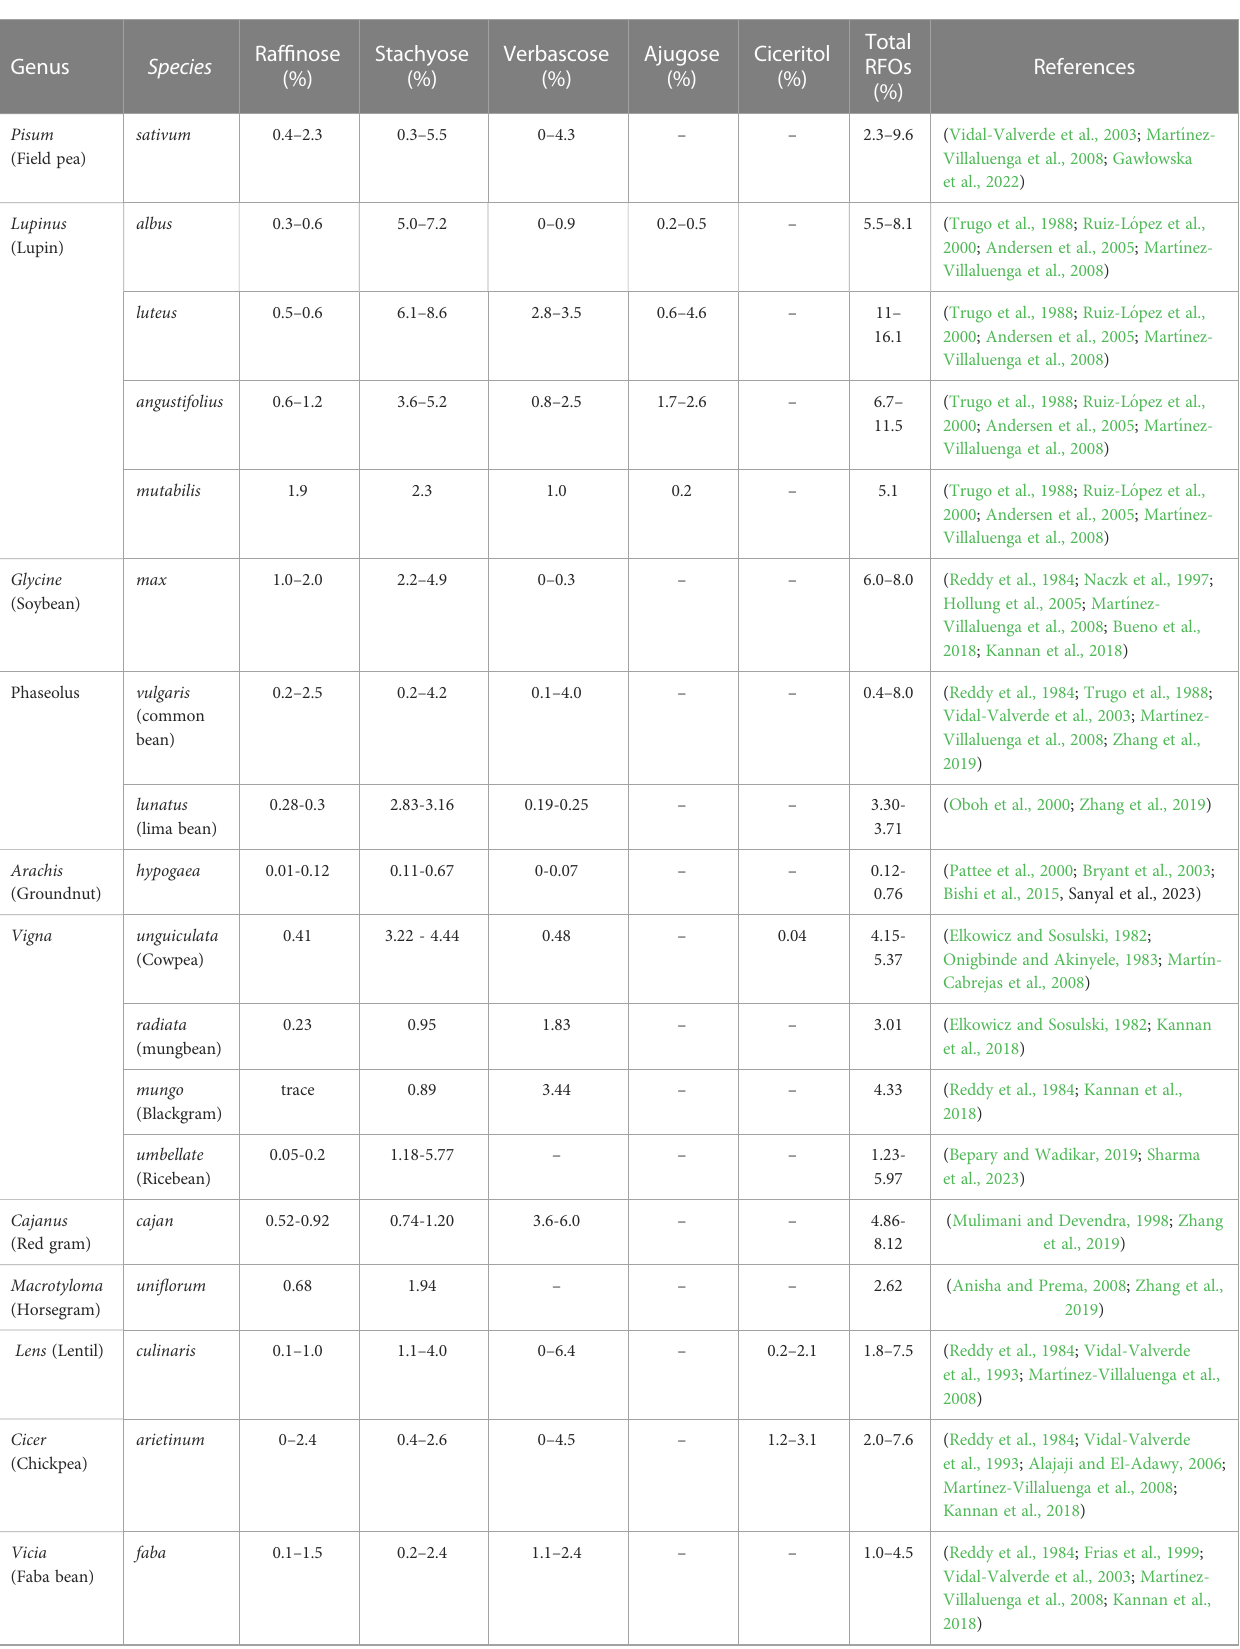
TABLE 1 Distribution of individual a -galactosides in commonly cultivated